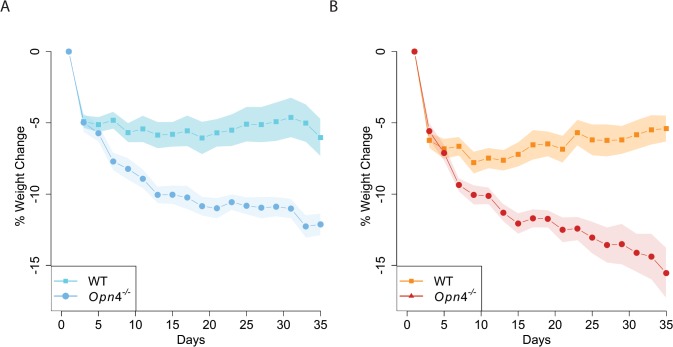

Opn4
-/- mice lose significantly more weight as compared to the WT controls over the course of 5 weeks of ketogenic diet exposure A) under a 12h:12h blue LD and B) under a 12h:12h red LD cycle.RM-ANOVA followed by Tukey-Kramer post hoc analysis: Opn4
-/- vs. WT in blue LD p = 0.0009; in red LD p = 0.0005. (Opn4
-/- vs. WT at the end of week 2: in blue LD p = 0.0002, in red LD p = 0.0009; end of week 3: in blue LD p = 0.0001; in red LD p = 0.0003; end of week 4: in blue LD p<0.0001, in red LD p<0.0001; end of week 5: in blue LD p<0.0001, in red LD p<0.0001. For the weekly contrasts, alpha value was adjusted to 0.0017—Dunn-Sidak correction for contrasts. Under both blue and red LD cycles: Opn4
-/- n = 9, WT n = 12)